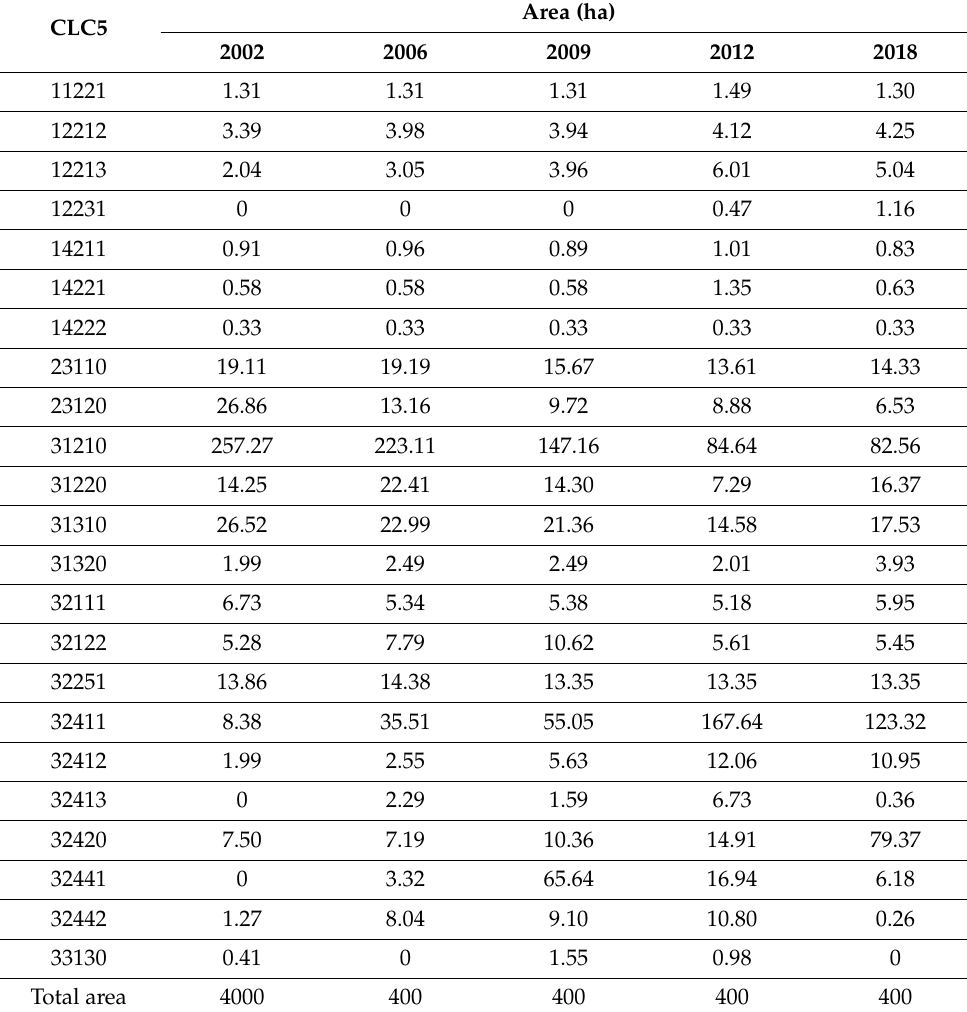
Table 7. Detailed development of land cover-changes in surroundings of ˇCertovica (NAPALT).